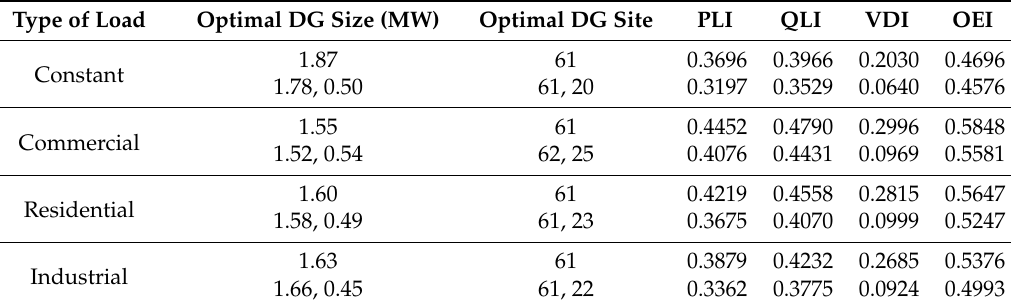
Table 5. Optimal size and site of DG and Indices values for OEI as objective.